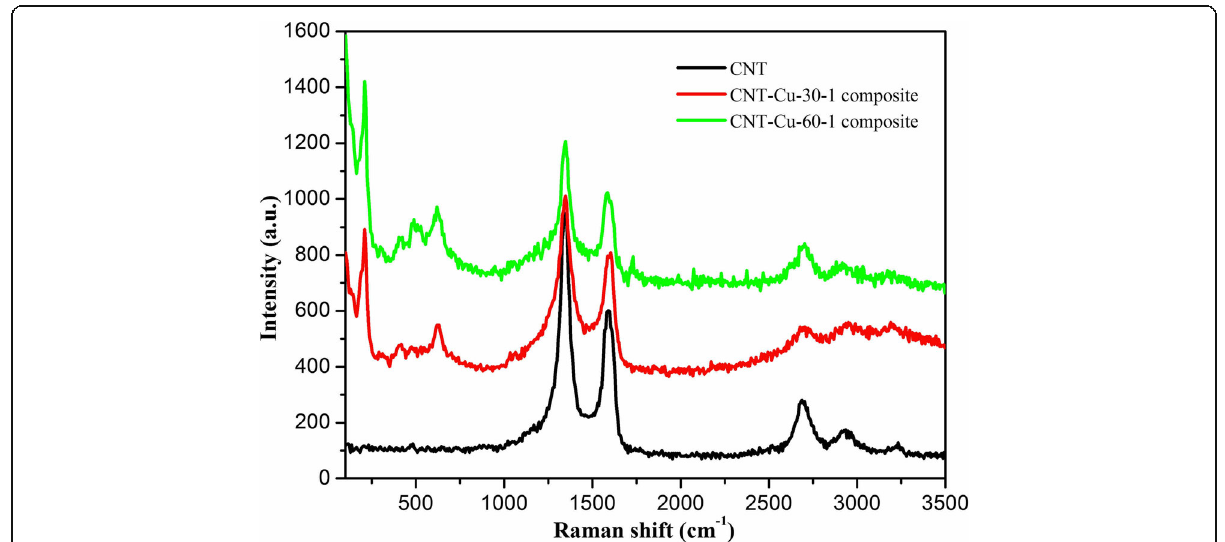
Fig. 4 Raman spectra of the CNT and synthesized CNT-Cu 2 O nanocomposites